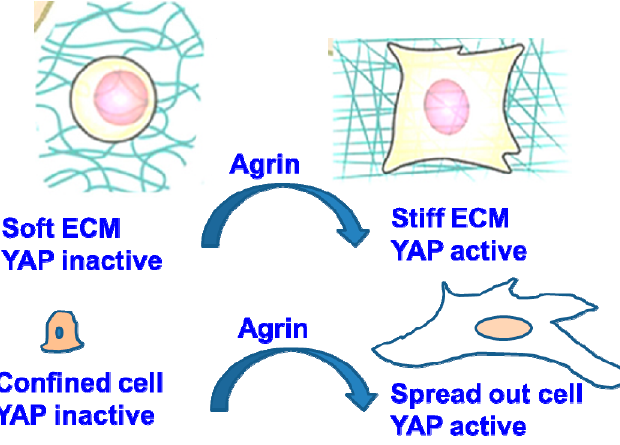
Figure 2. Role of agrin in maintaining YAP localization under altered Extracellular matrix ECM and cell geometrical shapes.